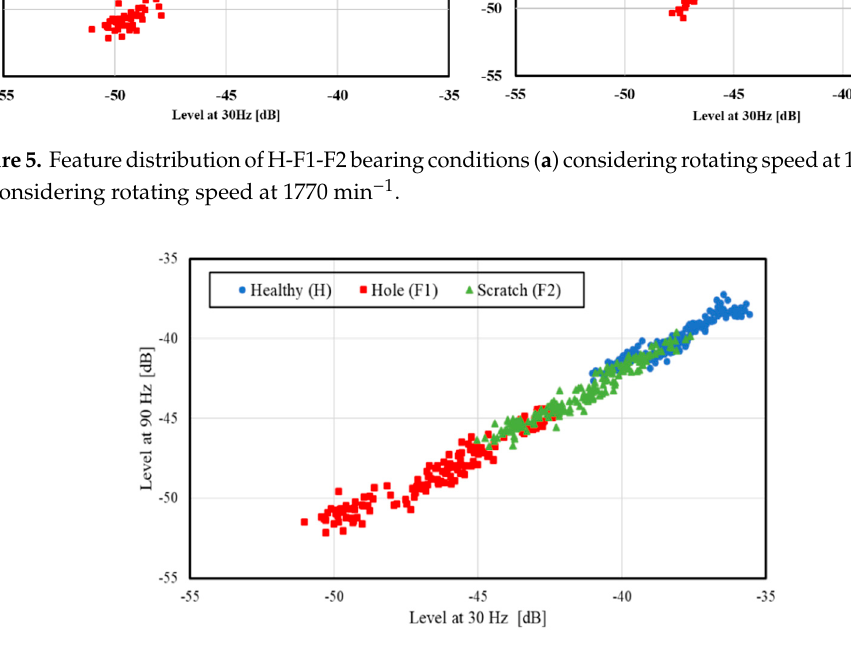
Figure 6. Feature distribution of H-F1-F2 bearing conditions without considering the rotating speeds.